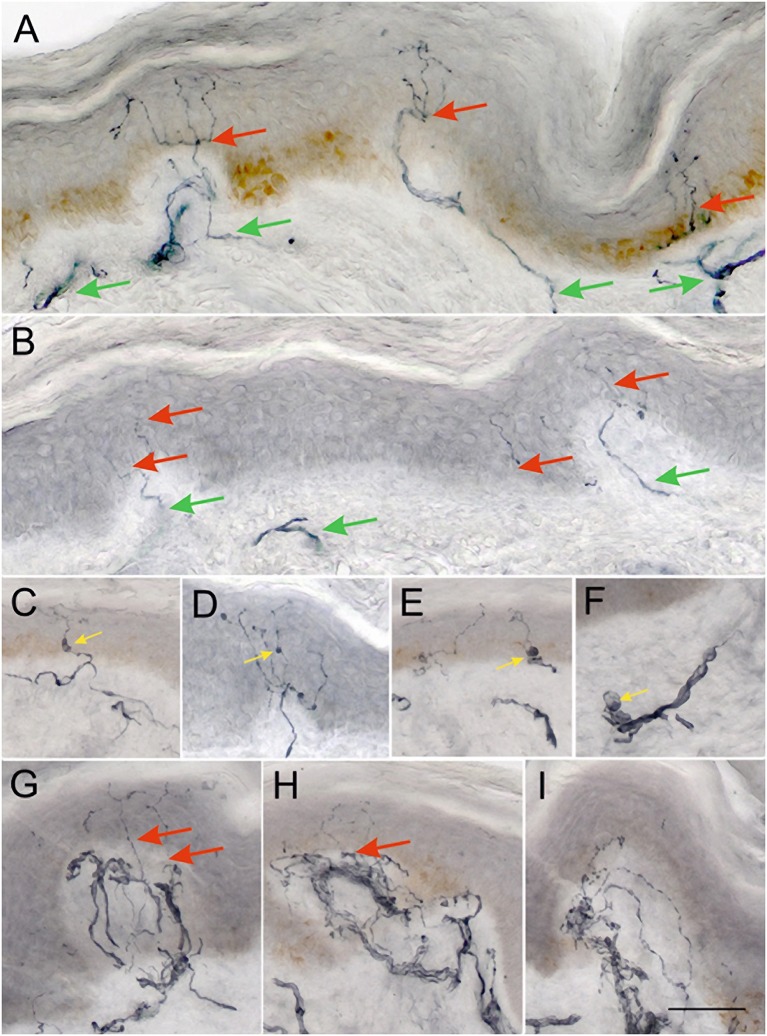
Representative examples of 50 μm sections from skin biopsies immunostained for GAP-43. Healthy control (A) shows numerous long branching intraepidermal nerve fibers (red arrows) reaching upper layers of epidermis and well-developed sub-epidermal nerve plexus (green arrows). Biopsy from a PD patient (B) showing scant, faintly staining intraepidermal nerve fibers (red arrows), and scant subepidermal plexus (green arrows). Images (C–E) show examples of axonal swellings along the IENFs and sub-epidermal nerve fibers (F) (yellow arrows). Images (G–I) show focal accumulations of nerve fibers in subepidermal area, which give rise only to occasional NFs crossing the BM into the epidermis (red arrows). Such areas are often separated by stretches of papillary dermis with very scant subepidermal plexus as in (B). (A–I) were taken at the same magnification ×200, scale bar = 100 μm.